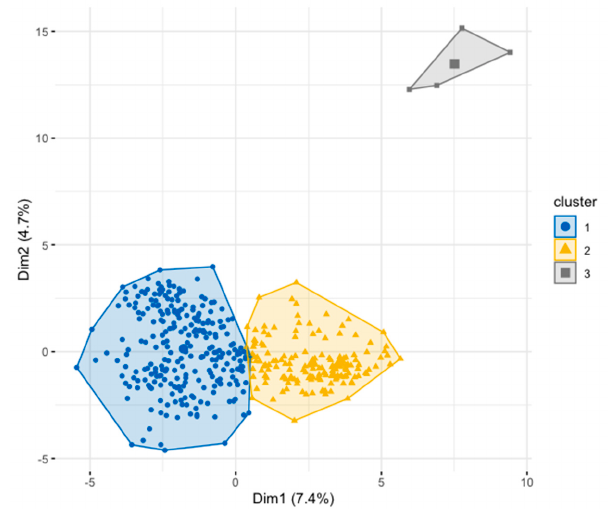
Figure 8. Cluster plots showing the number of clusters of the mango accessions revealed by the hierarchical cluster analysis based on both quantitative and qualitative data.